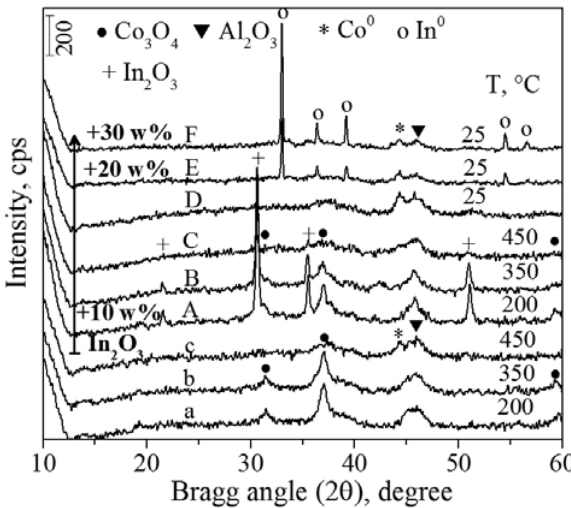
Fig. 1. HT-XRD patterns of the indium free 9Co/Al b, c) and 9Co/Al O /10% (A, B, C, D), /20% (E) and /30% (F) 2 3 In O mixtures, treated in H flow for 30 min at various reducing 2 3 2 temperatures. D, E and F curves were recorded at room temperatu- re following the reduction treatment up to 450 o C and cooling down in H 2